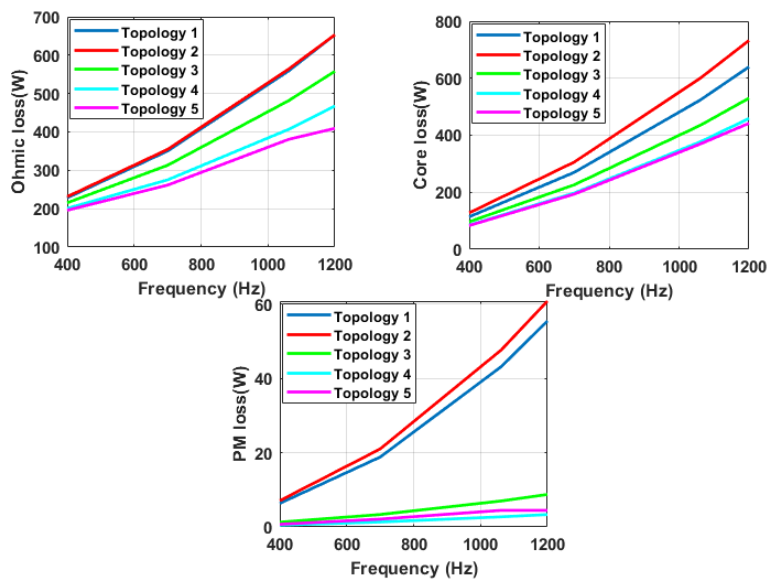
Figure 11. Comparison in terms of losses versus frequency among the five topologies